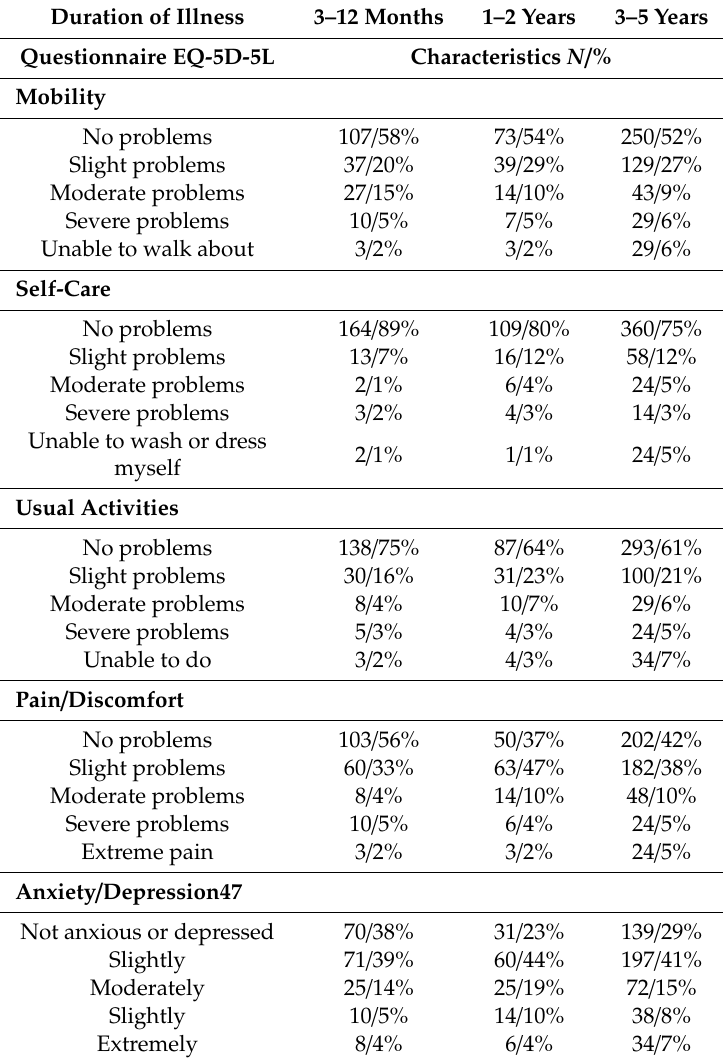
Table 5. EQ-5D-5L profile of patients by di ff erent disease